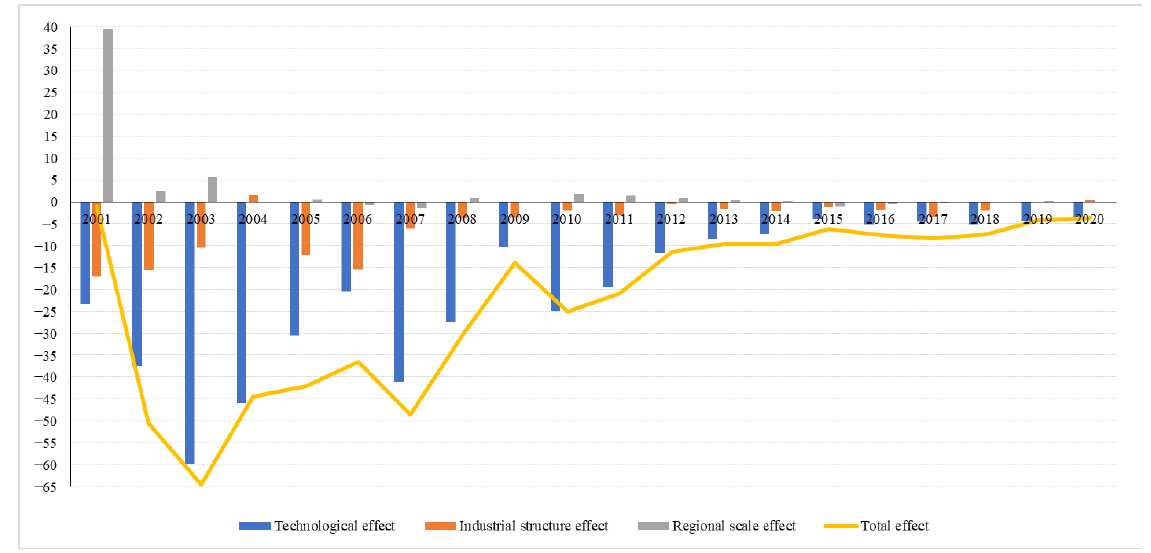
Figure 3. Effects and contribution rates in China from 2000 to 2020.